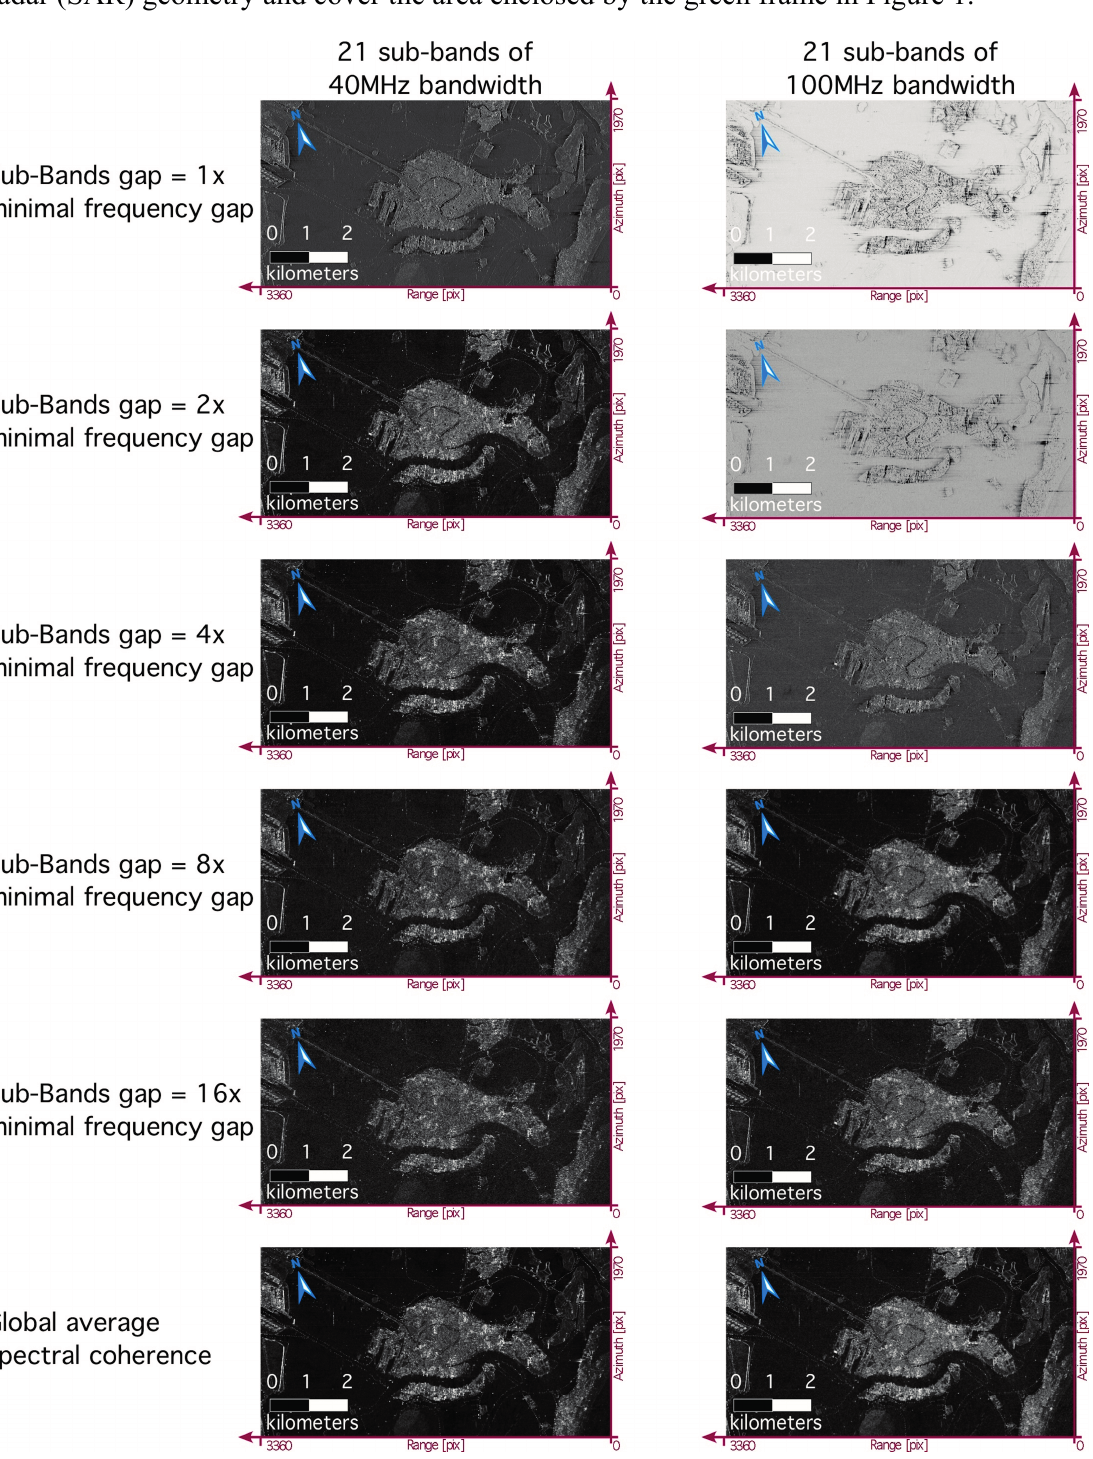
Figure 7. Comparison between spectral coherence images derived from the two different splitting schemes indicated at the top. Each image shows the average spectral coherence of all possible sub-band pairs separated by the same frequency gap, indicated at the left of each panel, in grayscale from 0 (black) to 1 (white). The maps are in synthetic aperture radar (SAR) geometry and cover the area enclosed by the green frame in Figure